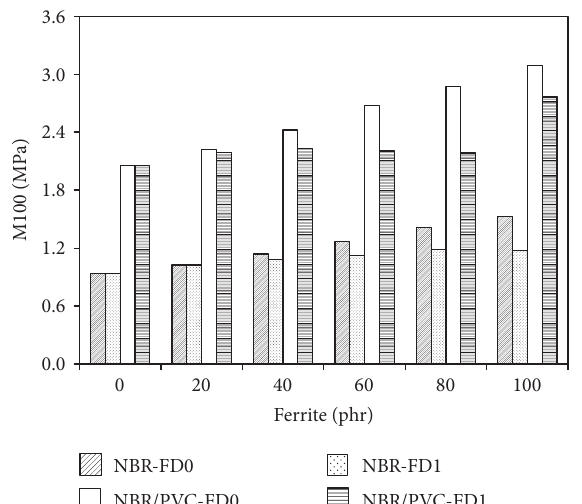
Figure 9: Influence of ferrites content on hardness of composites.